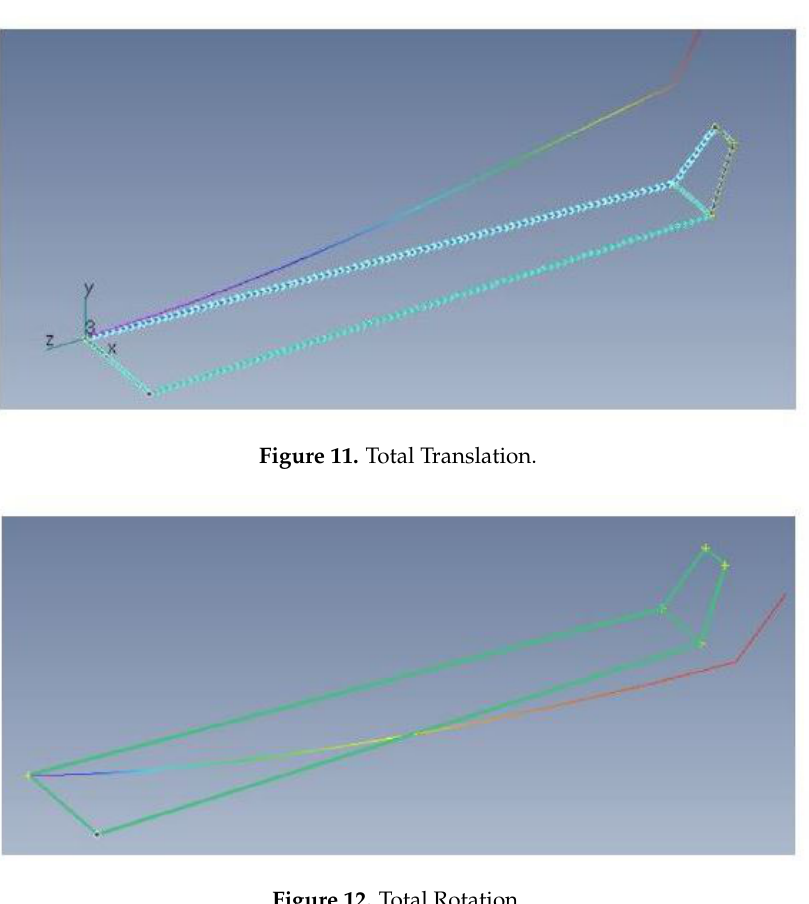
Figure 12. Total Rotation.